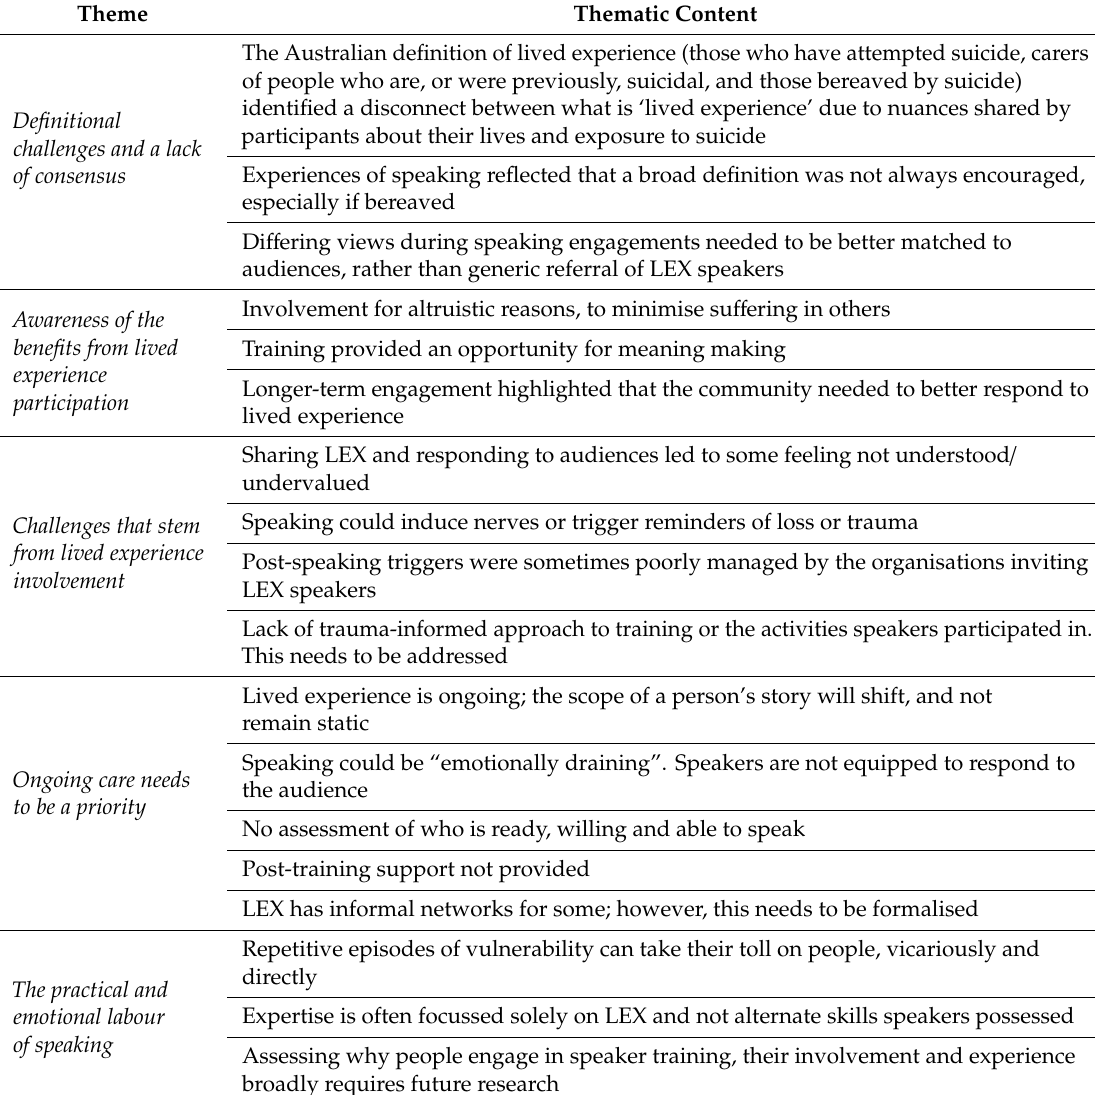
Table 2. Themes identified, lived experience (LEX) engagement in suicide prevention and impacts of